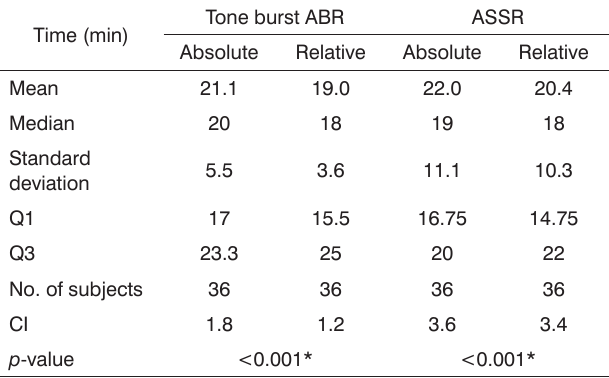
Table 3. Comparison between absolute and relative times, in minutes, of tone burst ABR and ASSR.